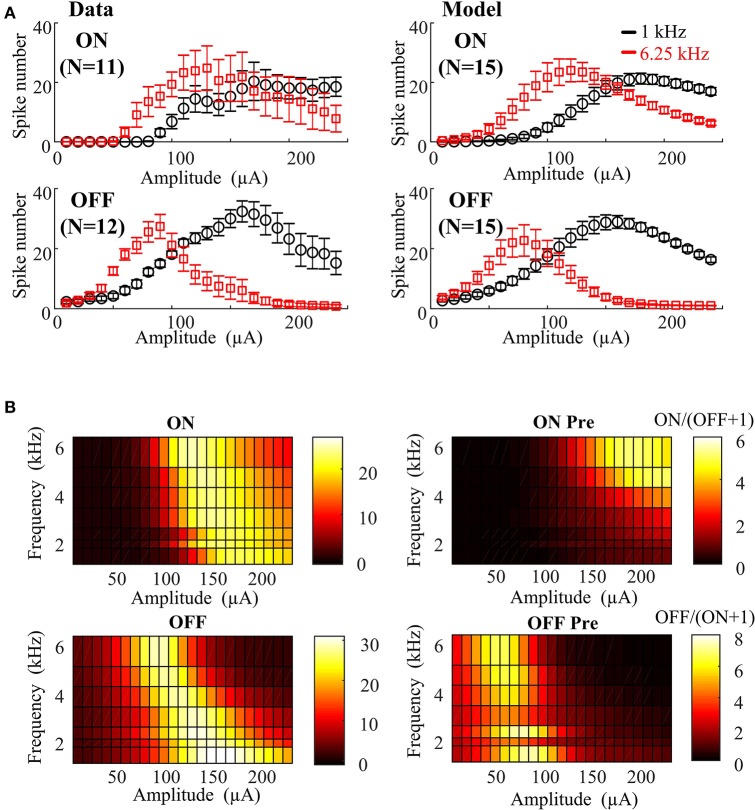
Empirical model closely replicating RGC activation observed experimentally under different stimulus frequencies and amplitudes. (A) Left panel: In vitro 1- and 6.25-kHz spiking responses against stimulus amplitude recorded in mouse ON (N = 11) and OFF (N = 12) RGCs with standard error bars. Right panel: 1- and 6.25-kHz spiking responses against stimulus amplitude simulated by the 15 virtual RGC populations. Fifteen sets of parameters were generated from a uniform random distribution centered around the default values. Maximum parameter deviations were set at ±30% of default values. (B) Stimulated RGC activation maps plotted based on mean values of the 15 model parameter sets.